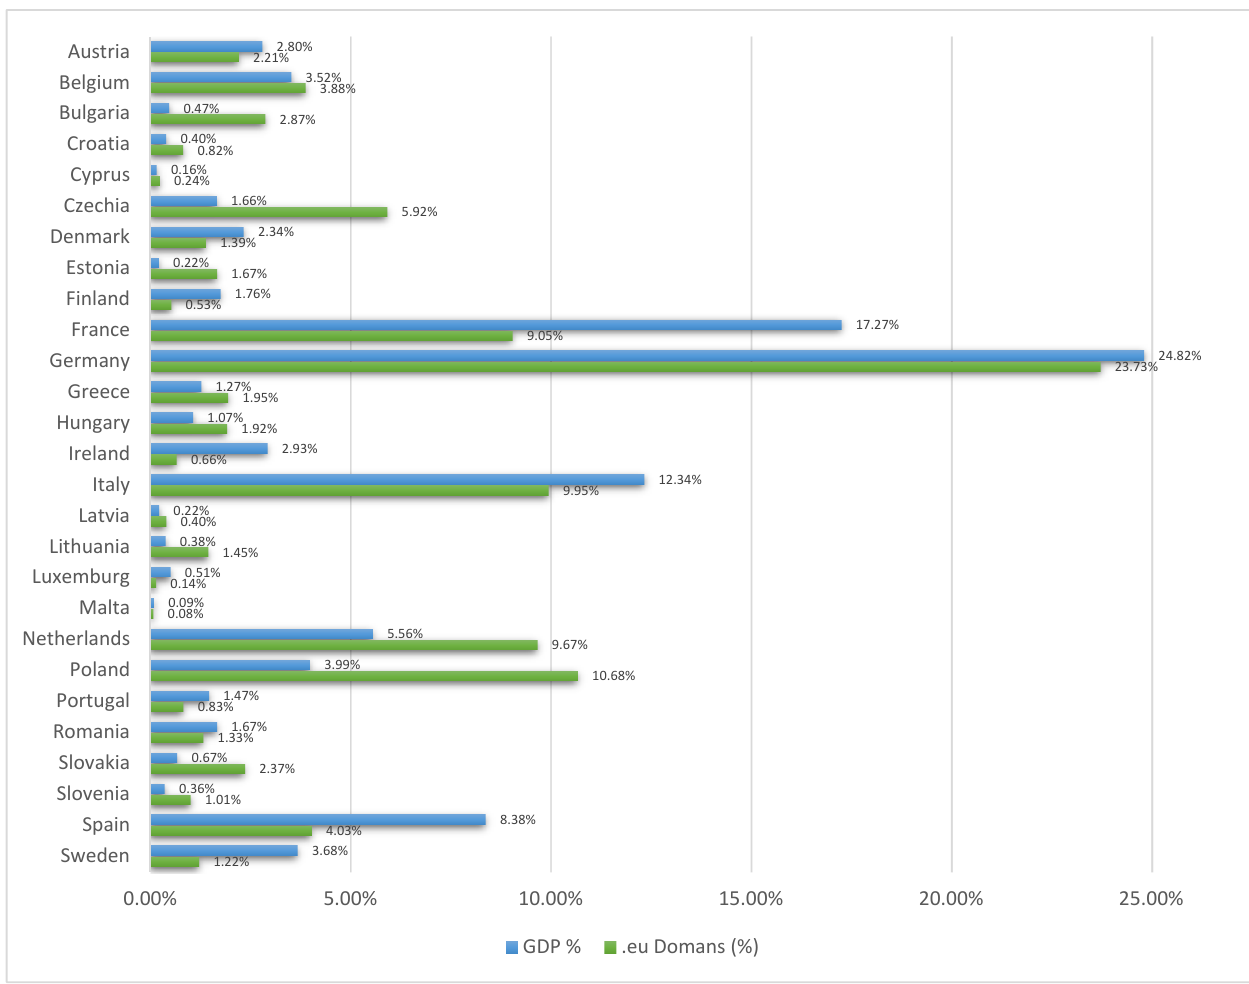
Figure 7. Percentage of EU domains vs. percentage of GDP per country.